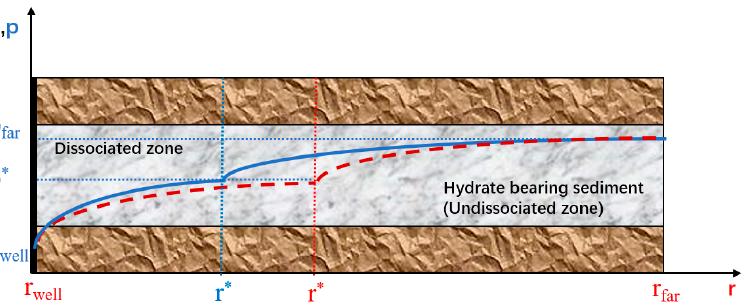
Figure 3. The diagram of pore-pressure distribution in hydrate formations in the case of constant well pressure.